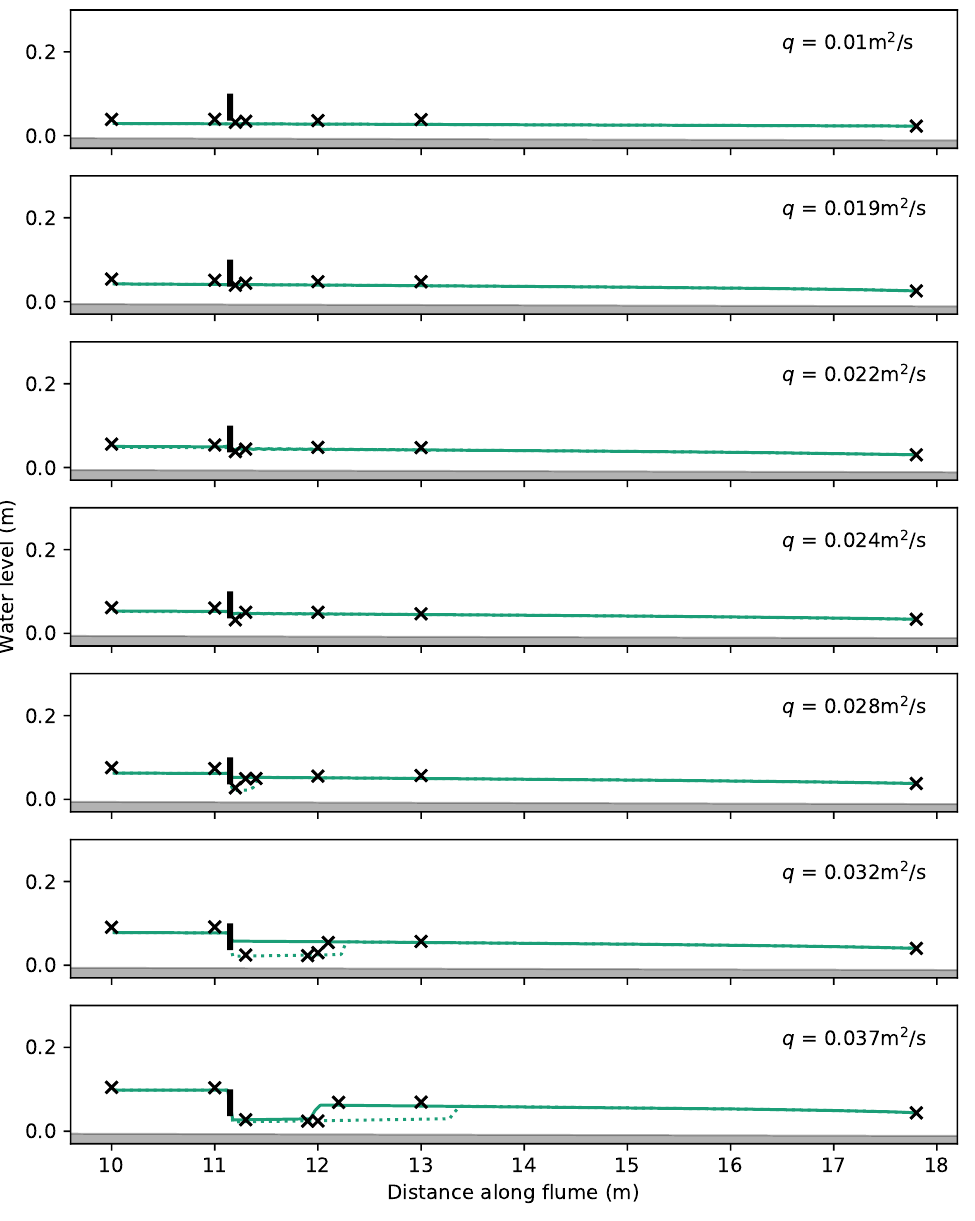
Figure A3. Results for configuration